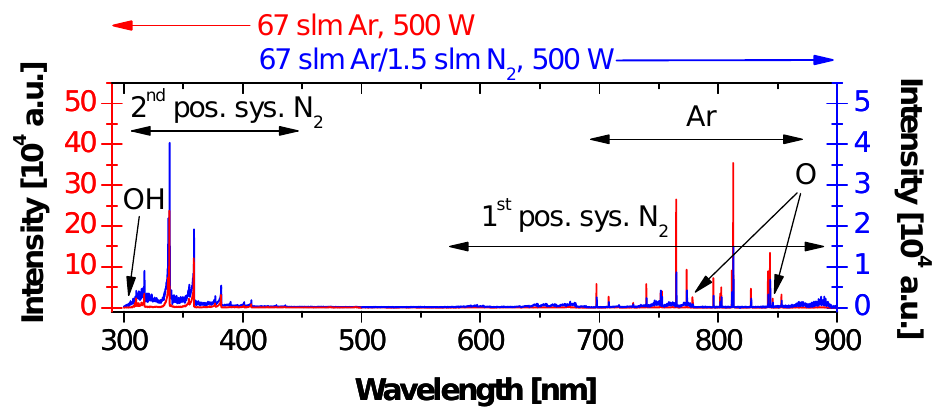
Figure 7. Optical emission spectra of PSJ obtained for Ar and Ar/N 2 gas feeds at the slit exit region. The intensity of Ar discharge emission (left vertical axis) is by one order of magnitude higher than the intensity of Ar/N 2 plasma (right vertical